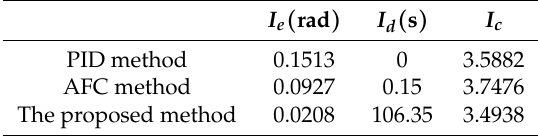
Table 4. Comparisons of quantitative evaluation indexes of the three methods.